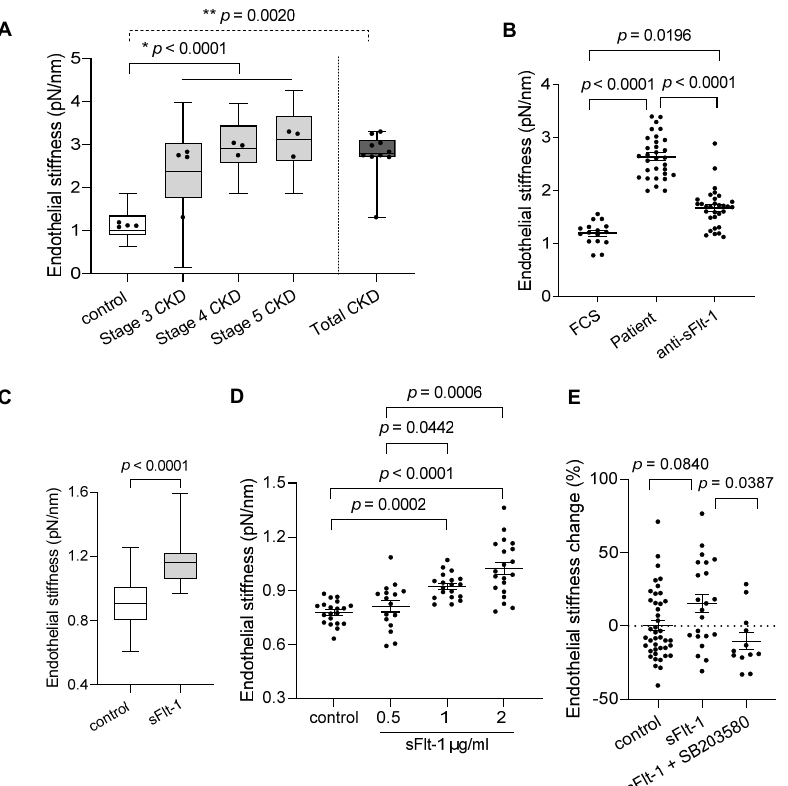
Figure 1. Chronic kidney disease patient sera and excess sFlt-1 stiffen endothelial cell cortex. ( A ) Endothelial stiffness of EA.hy926 cells was measured by atomic force microscopy (AFM) after 24 h of incubation with controls’ and patients’ sera. The values obtained (20–50 values/patient) were grouped according to the stage of CKD (stages three–five), plotted as box and whiskers, and were used for comparison among all three stages and controls (* p < 0.0001). Mean values obtained from each patient (dots) were used for comparison between Total (all patients) and controls (** p = 0.0020). ( B ) The graphic represents the effect of sFlt-1 neutralization by incubation with a specific antibody followed by immunoprecipitation in protecting cells against patient serum-induced stiffness. Values represent 15–30 measurements/treatments based on two independent experiments. Fetal calf serum (FCS) was used as a reference value (control). ( C ) Aortae from mice exposed to continuous in vivo administration of recombinant sFlt-1 (300 ng/h; N = 3) or control protein (IgG-Fc, 300 ng/h; N = 3) for three days were isolated and analyzed ex vivo by AFM. All values obtained (20–29 values/mouse) were plotted as box and whiskers and used for comparison between groups. Mean values obtained from individual mice are represented as dots. ( D ) Dose-response curve of human recombinant sFlt-1 (0.5–2 µ